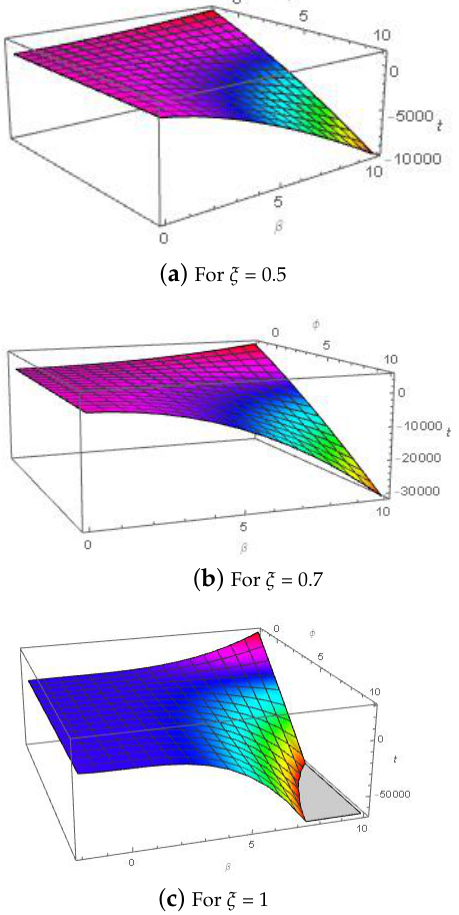
Figure 1. Representation of φ for different values of ξ